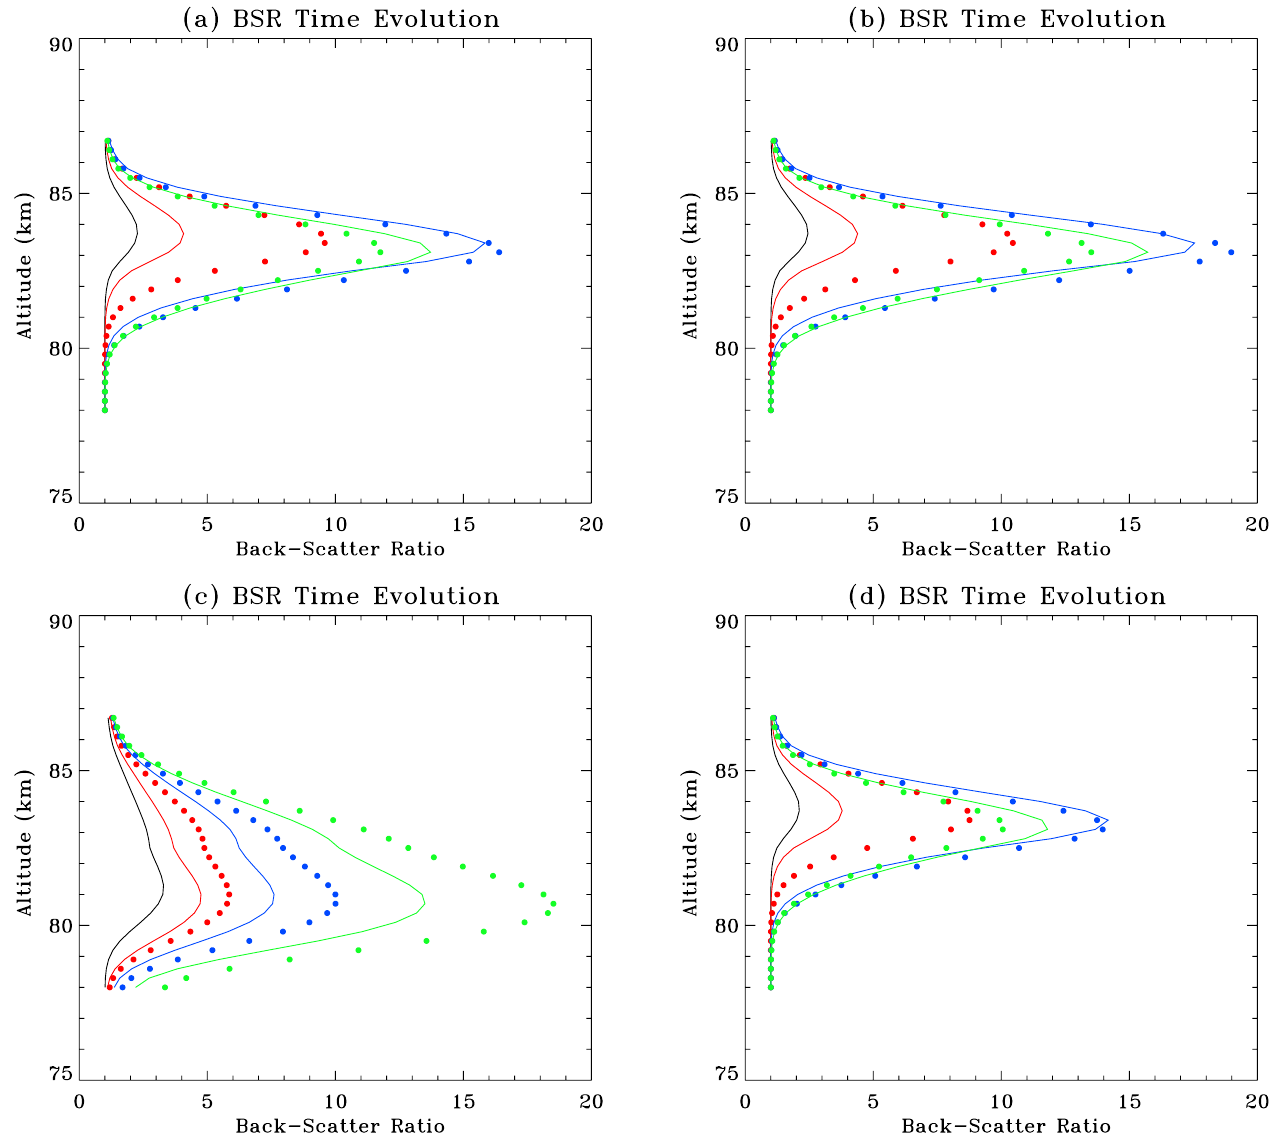
Fig. 3. Sensitivity tests – BSR time evolution at: (a) 135K, “base-line” case, with water vapour mixing ratio kept constant; (b) base-line temperature at 135K, water vapour mixing ratio increased by 5%; (c) 128K, 5% decrease in temperature from “base-line” while water vapour is kept constant at 4.7ppmv; (d) 5% decrease in water vapour mixing ratio, temperature kept constant at 135K. Simulation time after start: 3h (black); 6h (red, solid line), 12h (red, dotted line); 18h (blue, solid line); 24h (blue, dotted line); 30h (green, solid line), 36h – green, dotted